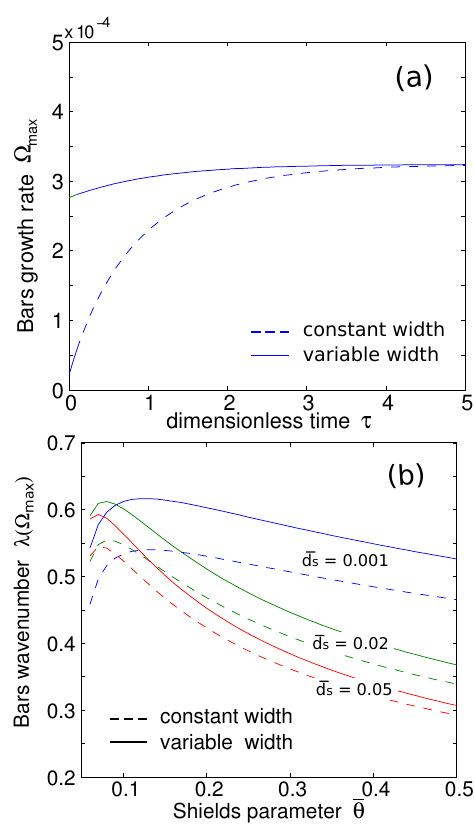
Fig. 4. Comparison between values predicted by applying the present theory (solid line) and the classical linear bar theory ap- plied by assuming steady flow at each temporal step (dashed line). (a) shows difference in maximum bar growth rate and (b) shows the values of the most unstable bar wavenumber plotted against the Shields parameter ¯ θ for different value of the roughness parameter ¯ d s at the initial time of the